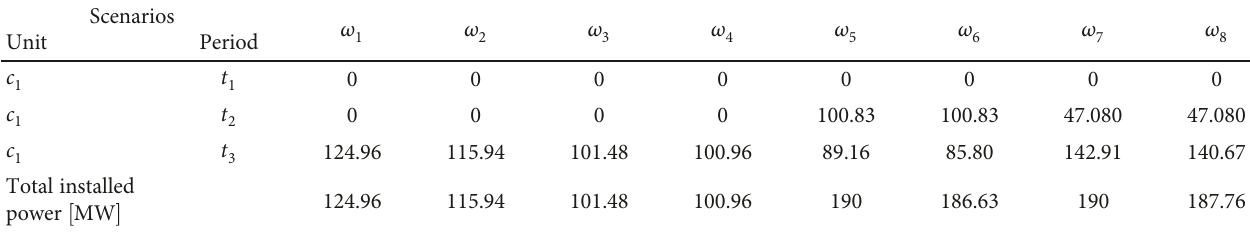
Table 5: Installed capacity for the candidate conventional energy MW .